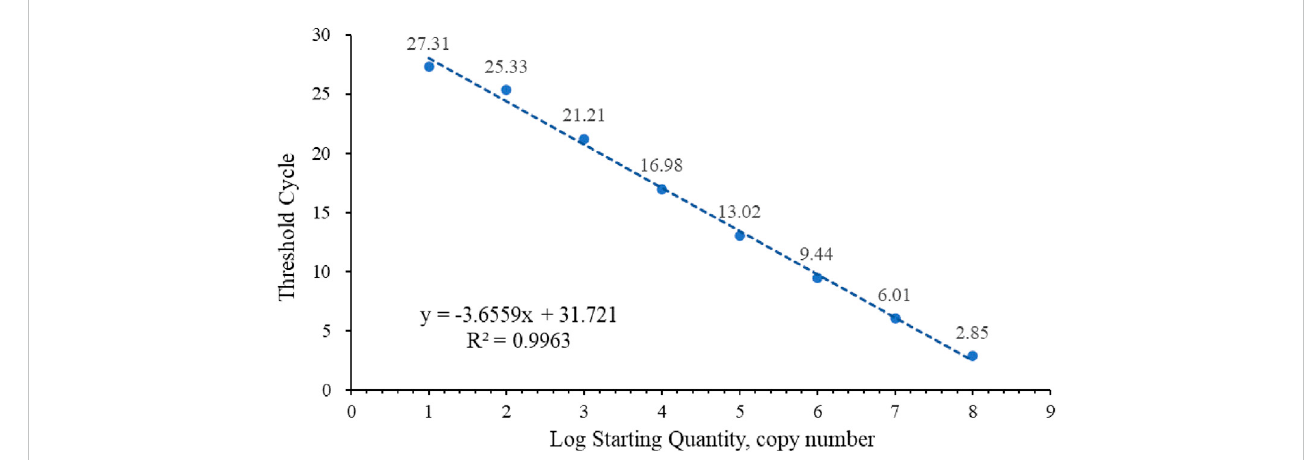
FIGURE 1 Standard curve of RBSDV-S10.